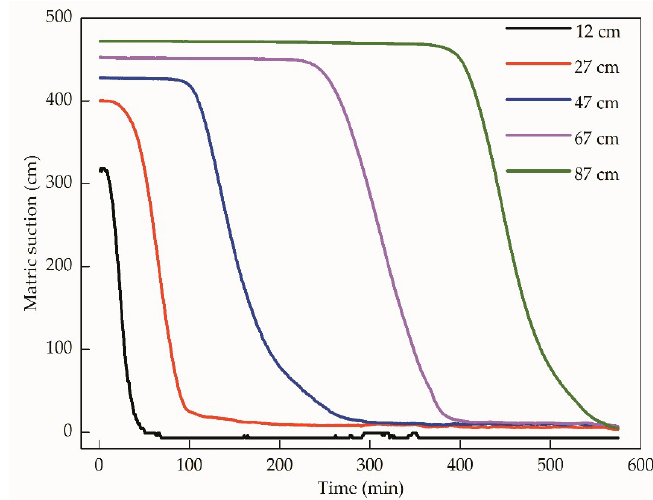
Figure 8. Variance in the matric suction with time at different depths.